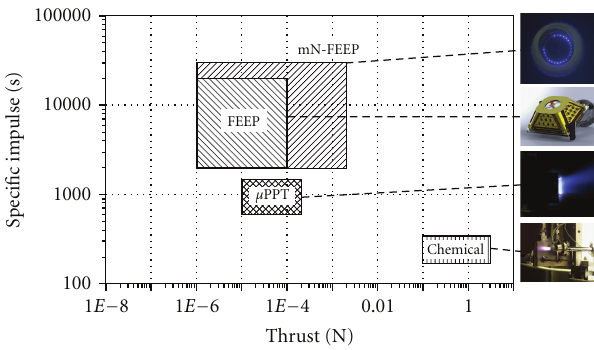
Figure 3: Indium reservoirs. Table 3: Summary of FEEP thruster